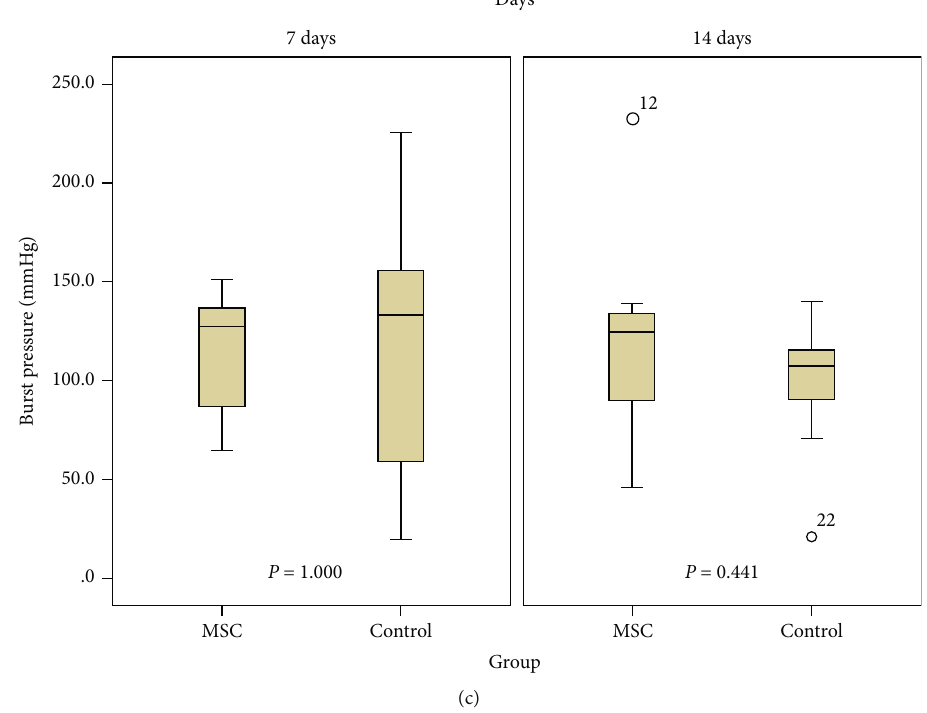
Figure 1: Comparison of burst pressures between the two groups. (a) Burst pressures of intact anastomoses at the 7 d timepoint in the MSC- treated group ( n = 11 ) and the control group ( n = 9 ). (b) Burst pressures of intact anastomoses at the 14 d timepoint in the MSC-treated group ( n = 15 ) and the control group ( n = 16 ). (c) Comparison of burst pressures between the two